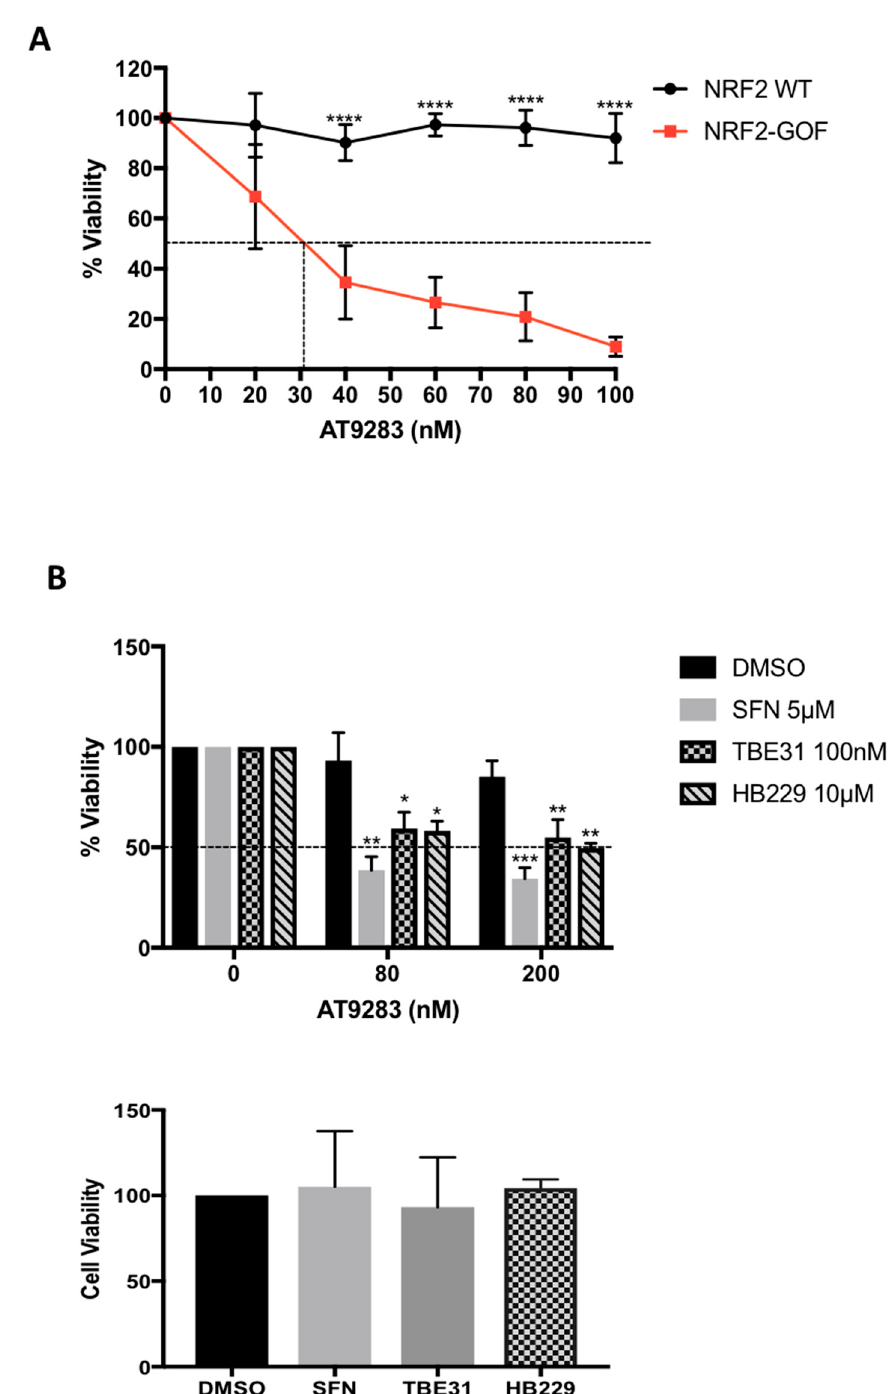
Figure 4. Validation of the selectivity of AT9283 against active NRF2. ( A ) NRF2-WT and GOF DLD1 cells were exposed to increasing concentrations of AT9283, as indicated. After three days, cell viability was measured using Alamar blue. Data represent means ± SD ( n = 4) and are expressed relative to the DMSO control, which was set as 100%. ( B ) Upper panel: DLD1 cells were pretreated with the indicated concentrations of NRF2 inducers or with DMSO, as indicated. After 24 h, fresh media with either DMSO or 80-nM or 200-nM AT9283 was added, and NRF2 inducers were replenished. On the next day, the NRF2 inducers were added again, and 24 h later, the cell viability was measured using Alamar blue ( n = 3). The viability of all control cells (without AT9283) were set as 100%. Lower panel: The cell viability of control cells (without AT9283) treated with the different NRF2 inducers is shown. * p ≤ 0.05, ** p ≤ 0.01, *** p ≤ 0.001, **** p ≤ 0.0001